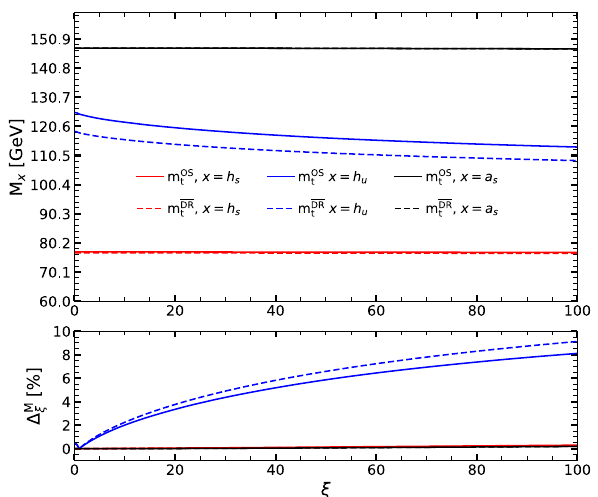
Fig. 15 Upper panel: The CP-even singlet-like (red), the SM-like (blue), and the CP-odd singlet-like (black) masses as a function of the gaugeparameter ξ attwo-loop O (α t α s + α 2 t ) levelintheOS(solidlines) and the DR (dashed lines) scheme of the top/stop sector. The dashed black line is hidden under the solid black line. Lower panel: Absolute value of the relative ξ dependence of the loop-corrected masses (cid:20) M ξ ( x = h s , h u , a s ) defined in the main text in Eq. (5.33), in percent, as a function of ξ . The color code in the lower plot is the same as in the upper